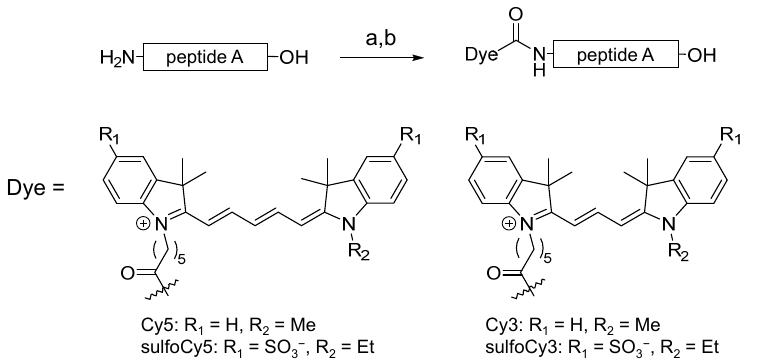
Figure 1. Synthetic scheme of dye-peptide A conjugates. Conditions and reagents: ( a ) Dye-SE, DMSO, 0.1 M Na 2 HPO 4 aq.; ( b ) TFA.